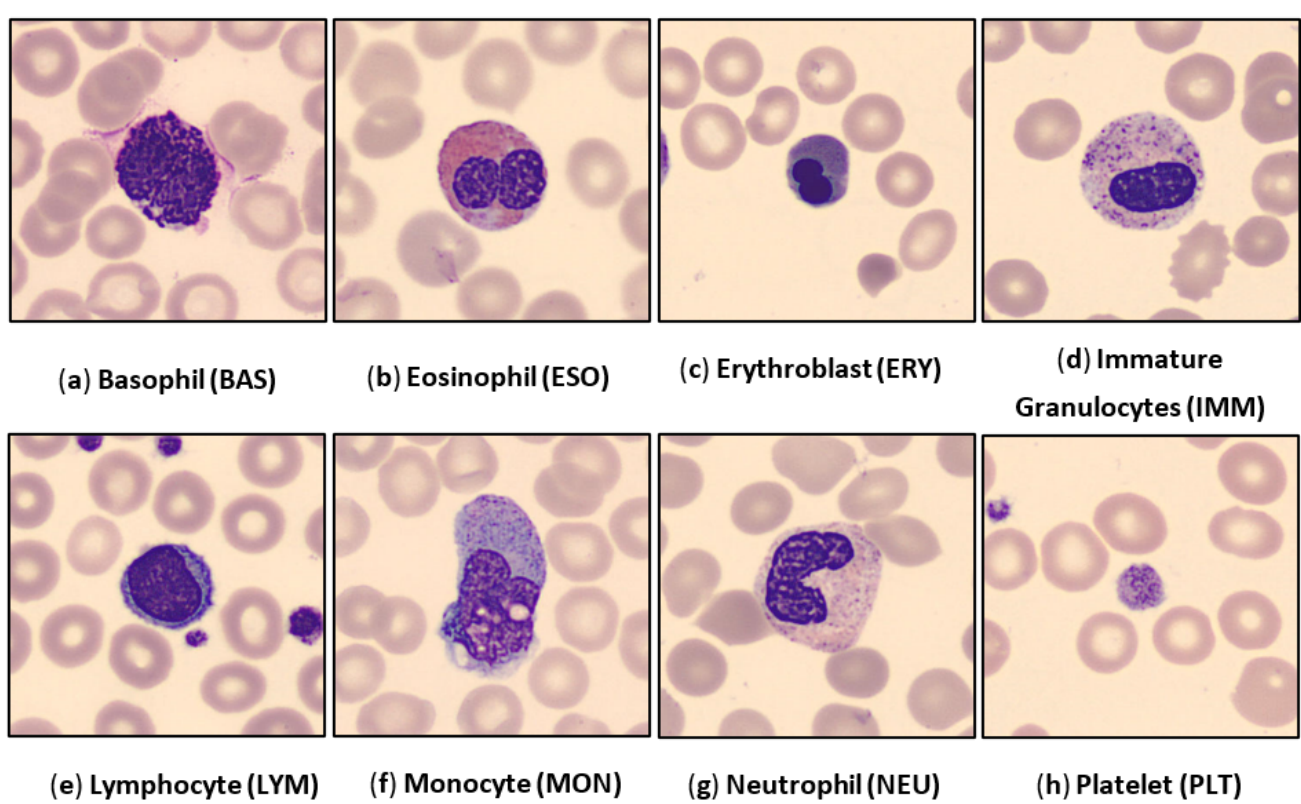
Figure 1. Examples of the human peripheral blood cell (HPBC) images over all eight classes.